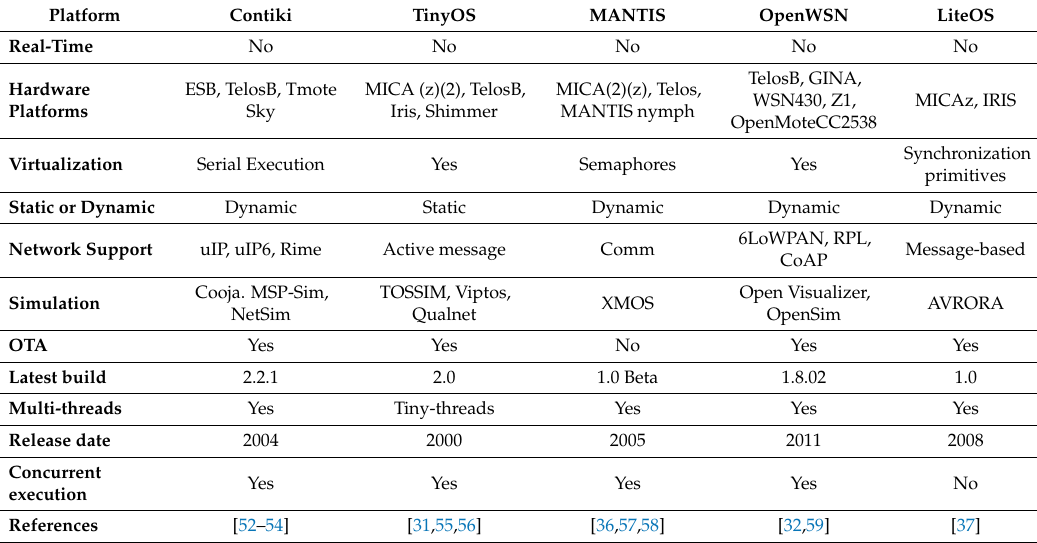
Table 1. A comparison of some of the operating systems of